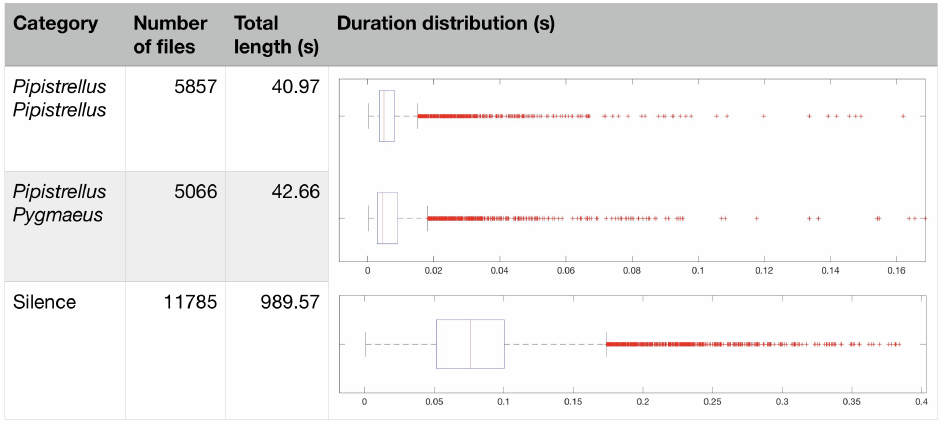
Figure 7. Total number of audio segments obtained after the initial audio files have been split into the calls and silences, duration, and duration distribution of each bat species and silence.